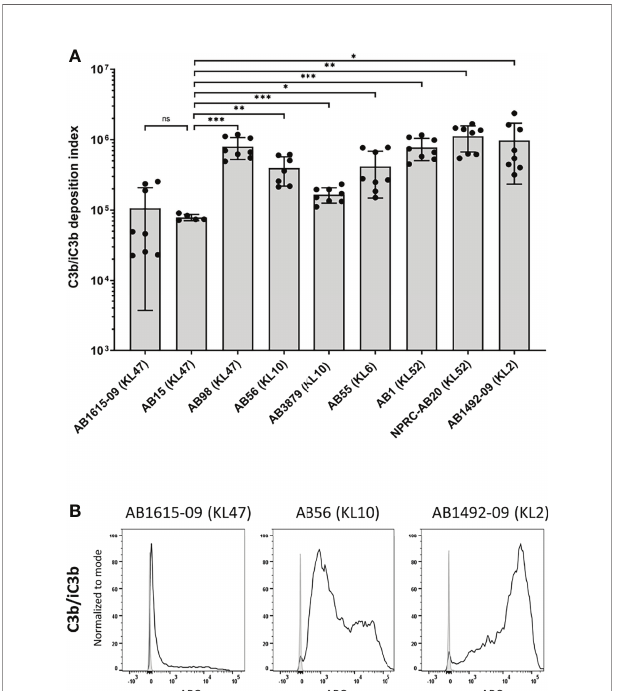
FIGURE 3 | Complement component C3b/iC3b deposition on the surface of clinical A. baumannii isolates. 10 6 CFU of bacteria was incubated with 25% normal human sera followed by incubation with the mouse monoclonal antibody 6C9 (Millipore) and detected using an anti-mouse IgG conjugated to allophycocyanin (APC) (Jackson Immunoresearch) (A) Bar graph showing the C3b deposition index computed by multiplying the percentage of bacteria staining positive for C3b/iC3b deposition and the median fl uorescent intensity of the positive population (%Pos*MFI). (B) Representative histograms showing the deposition of C3b/iC3b on 1x10 6 CFU of the three A. baumannii isolates. Each graph shows a grey histogram that represents bacteria labelled with primary and secondary antibody only and black solid line represent bacteria incubated with normal human sera. Bars represent mean values for each strain and the error bars indicate standard deviations (SDs) (n=8). T-test was used for statistical analysis *: p-value < 0.05, **: p-value < 0.01, ***: p-value < 0.001, ns: p-value > 0.05. Pooled data from three independent experiments is shown.